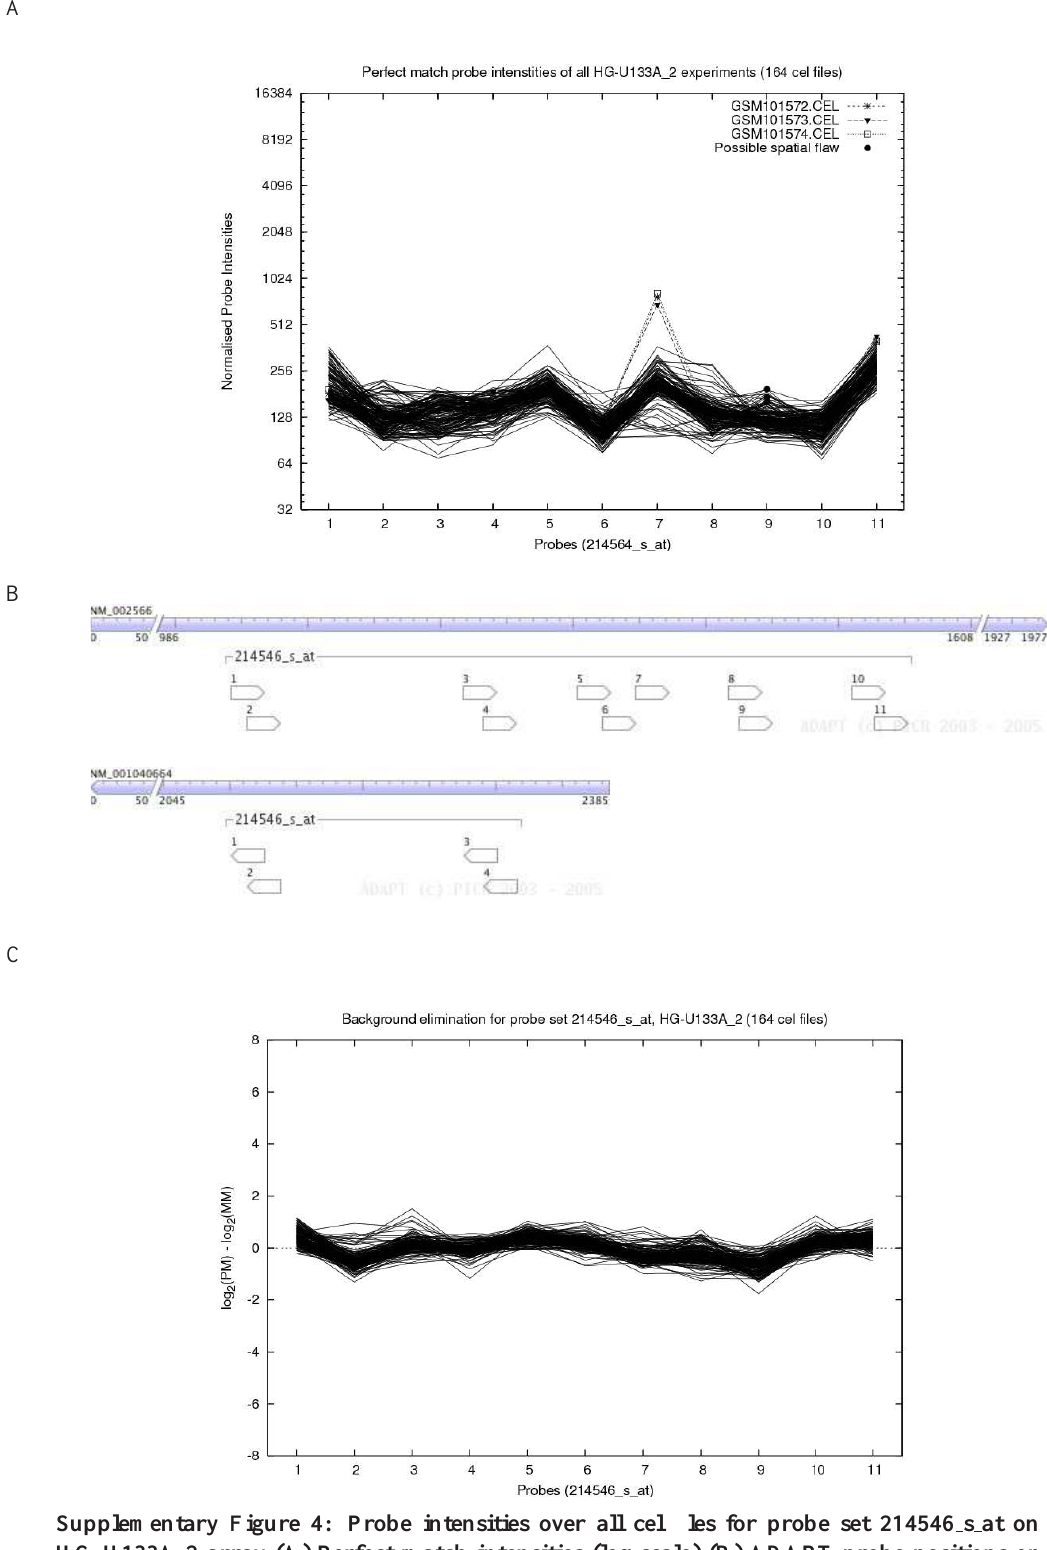
Supplementary Figure 4: Probe intensities over all cel files for probe set 214546 s at on the HG U133A 2 array (A) Perfect match intensities (log scale) (B) ADAPT probe positions on the transcripts (C) Background elimination (log 2 (PM) - log 2